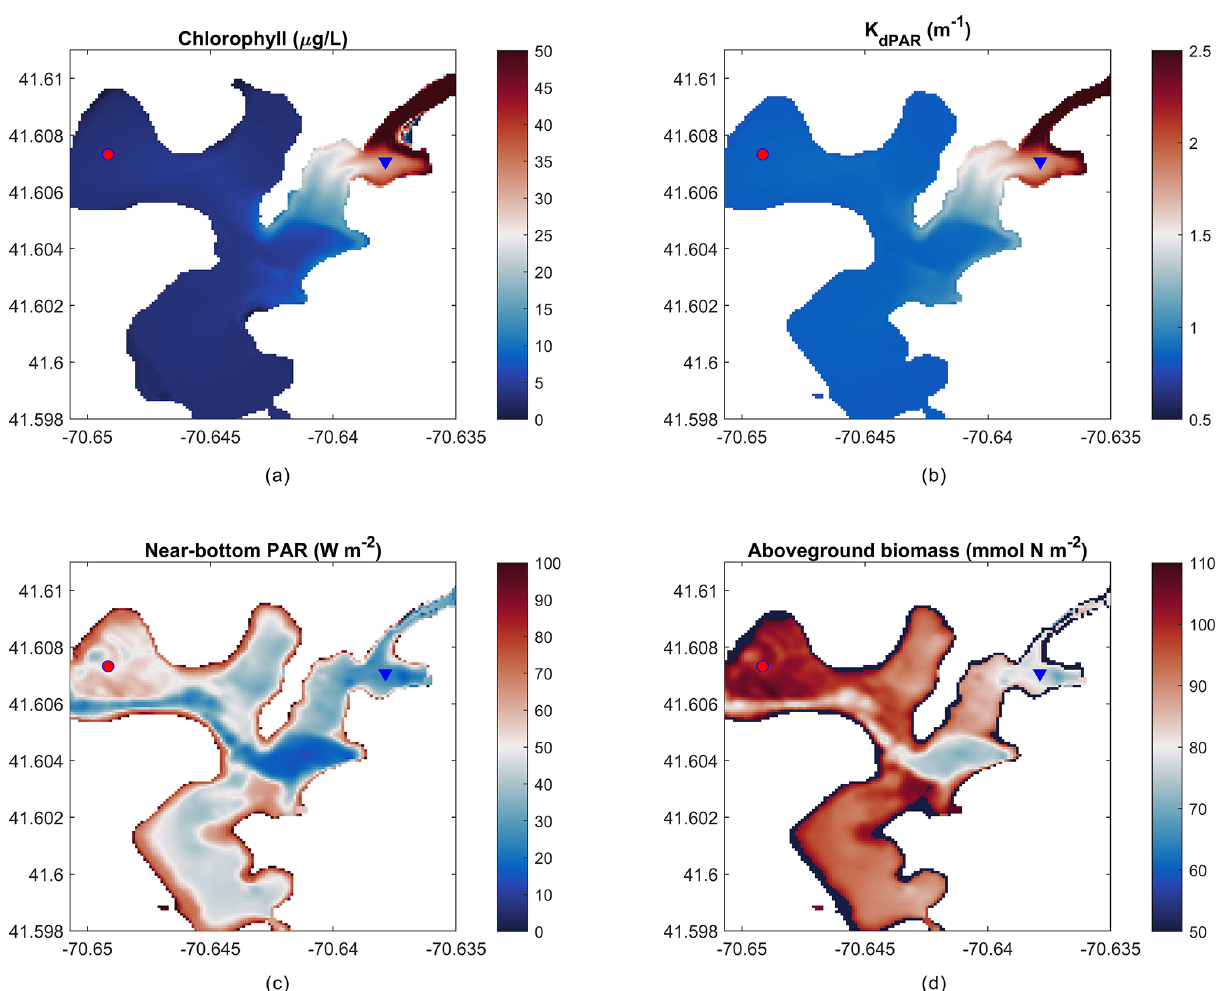
Figure 8. Mean over 22d of (a) depth-averaged chlorophyll, (b) light attenuation, (c) near-bottom PAR, and (d) peak aboveground biomass on day 14 of the simulation. The red circle indicates the outer harbor (a, c) and the blue triangle indicates the inner harbor (b, d) points for time-series data in Fig.